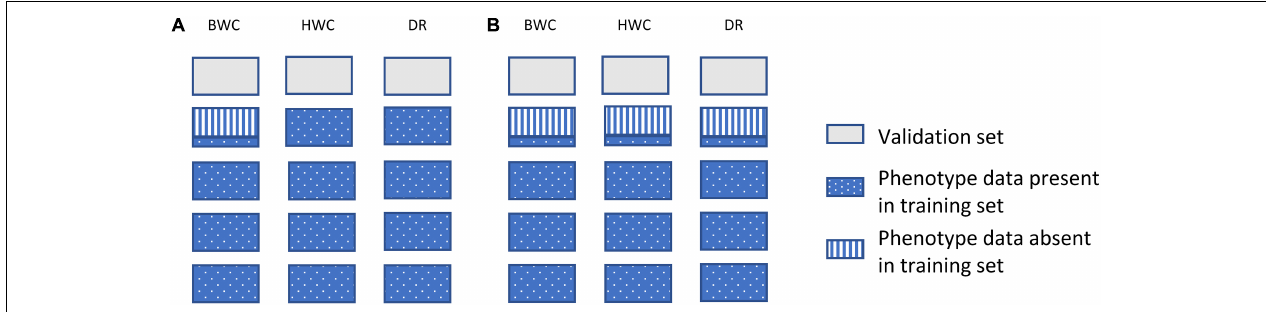
FIGURE 2 | Data used for ST-GBLUP and MT-GBLUP prediction in CV1. Each box indicates the presence or absence of phenotypic data for a particular trait in either the training or validation set. The presence and absence of phenotypic data are indicated by blue dotted (phenotypic data present in the training set), gray (phenotypic data absent in the validation set), and blue vertical stripes (phenotypic data absent in the training set). The phenotypic information for HWC and FT was either kept as complete in the training set (A) or set to missing when BWC was missing (B) .